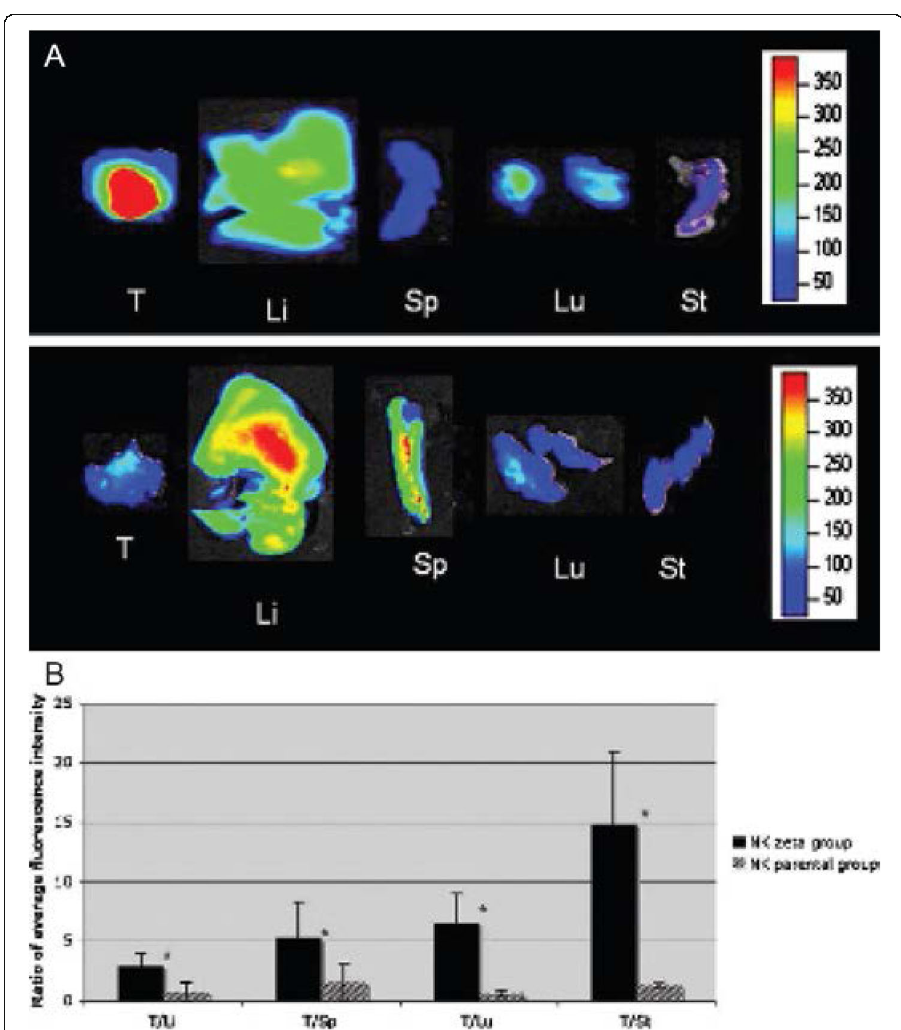
Fig. 5 Ex vivo optical imaging (OI) study. OI of explanted tumors and organs of two representative animals at 24 h after NK92-scFv(MOC31)-zeta cell injection (upper panel) or NK-92 cell injection (lower panel). Following NK-92-scFv(MOC31)-zeta cell injection, a marked fluorescence of the tumor was noted, which was higher in intensity compared with the explanted organs. Following NK-92 cell injection, the tumor did not show an increased fluorescence. Li = liver; Lu = lungs; Sp = spleen; St = sternum; T = tumor. (adapted from Tavri et al.) (Tavri et al.